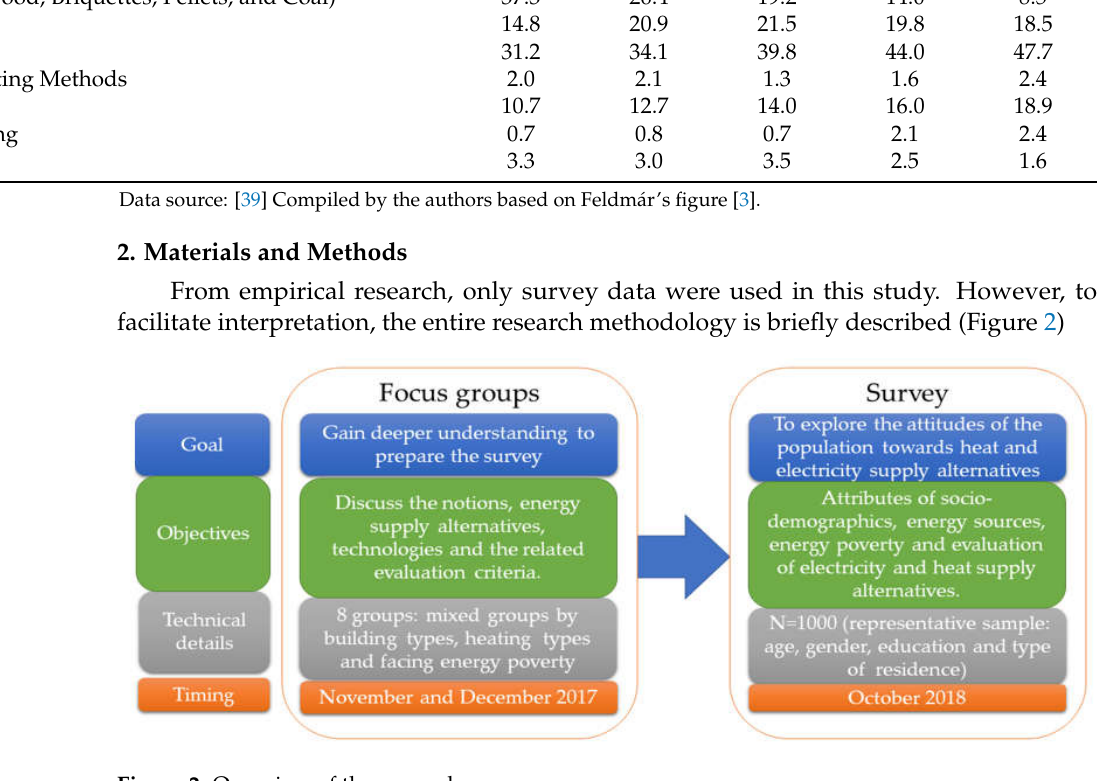
Table 1. Share of households by source of heating by income quintiles percentage (2019).